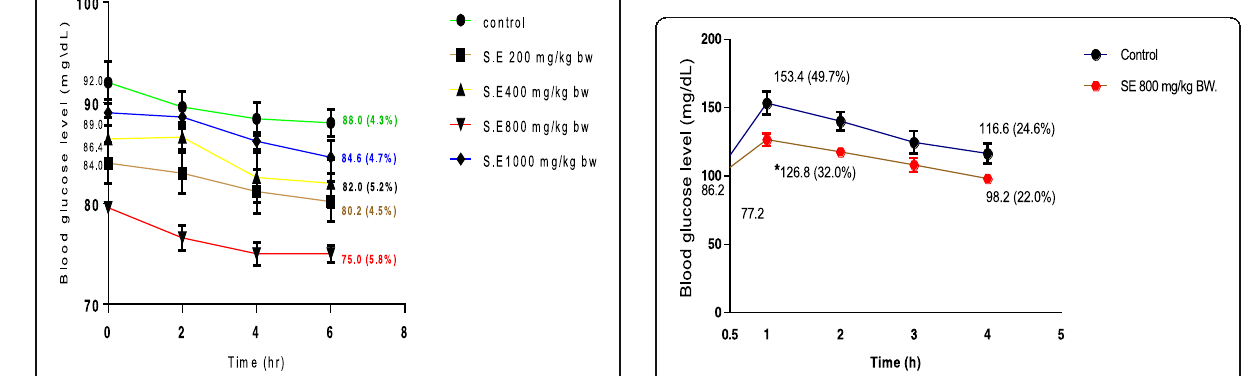
Fig. 2 Oral glucose tolerance effect of SE in normoglycemic rats. Values are expressed as mean of six rats. Figures in parentheses are mean percentage reduction in fasting blood glucose level (FGBL). * = significant when compared to